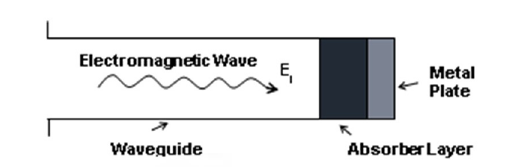
Figure 2. Schematic of a transmission-reflection line method in a waveguide with a sample characterized with a metal plate (Ei - incident wave, Ea - absorbed